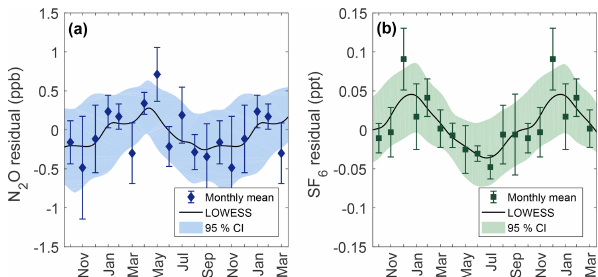
Figure 6. Seasonality for N 2 O (a) and SF 6 (b) calculated from the residuals of observed data points to the secular trend. The black line is a LOWESS fit to residuals with a smoothing window of 1 month. Data points show the observed monthly mean residual af- ter binning by month with error bars representing the standard error within the month. Shaded areas are 95% CI calculated from 1000 bootstrapped LOWESS fits while including the measurement uncer- tainty to each data